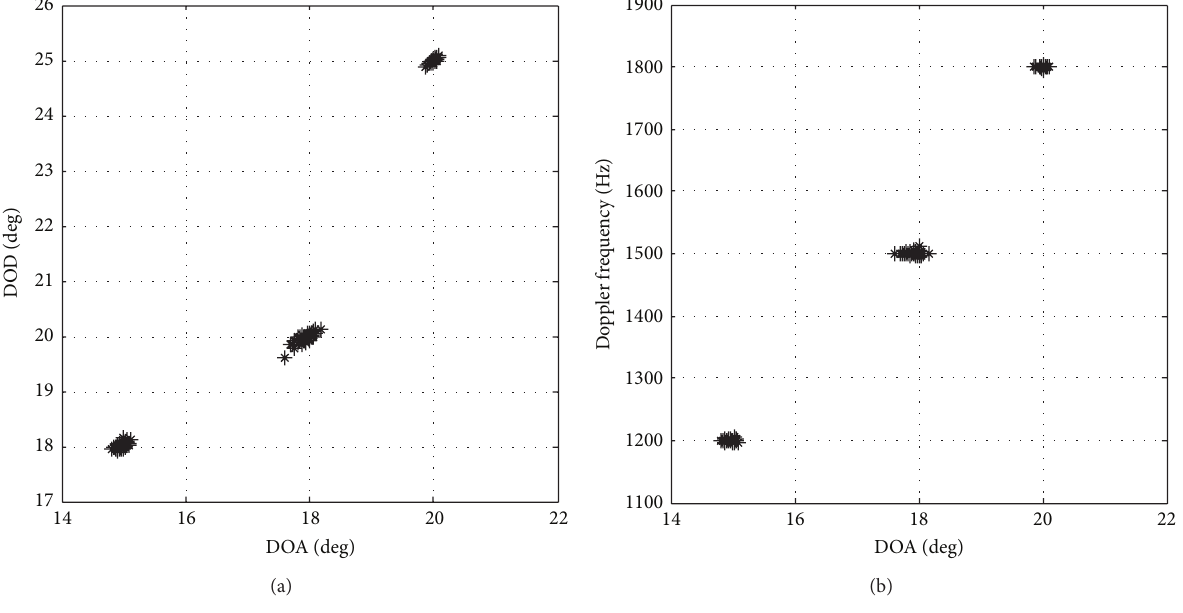
Figure 7: Angle and Doppler frequency estimation at SNR =